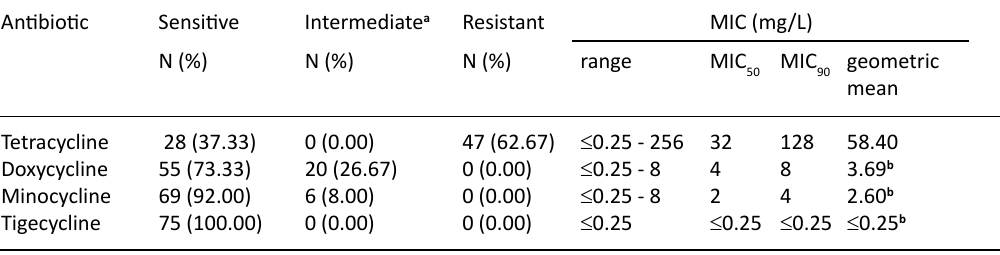
table 2. Susceptibility overview of the 75 MRSA isolates to tetracyclines Antibiotic